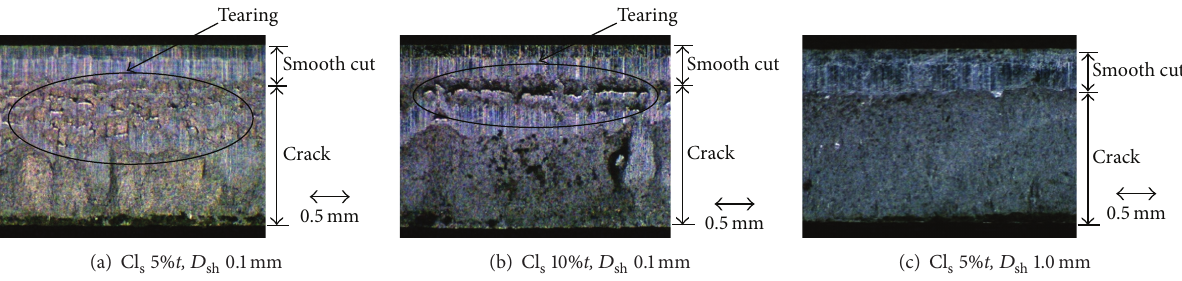
Figure 4: An example of shaved surface of SAPH